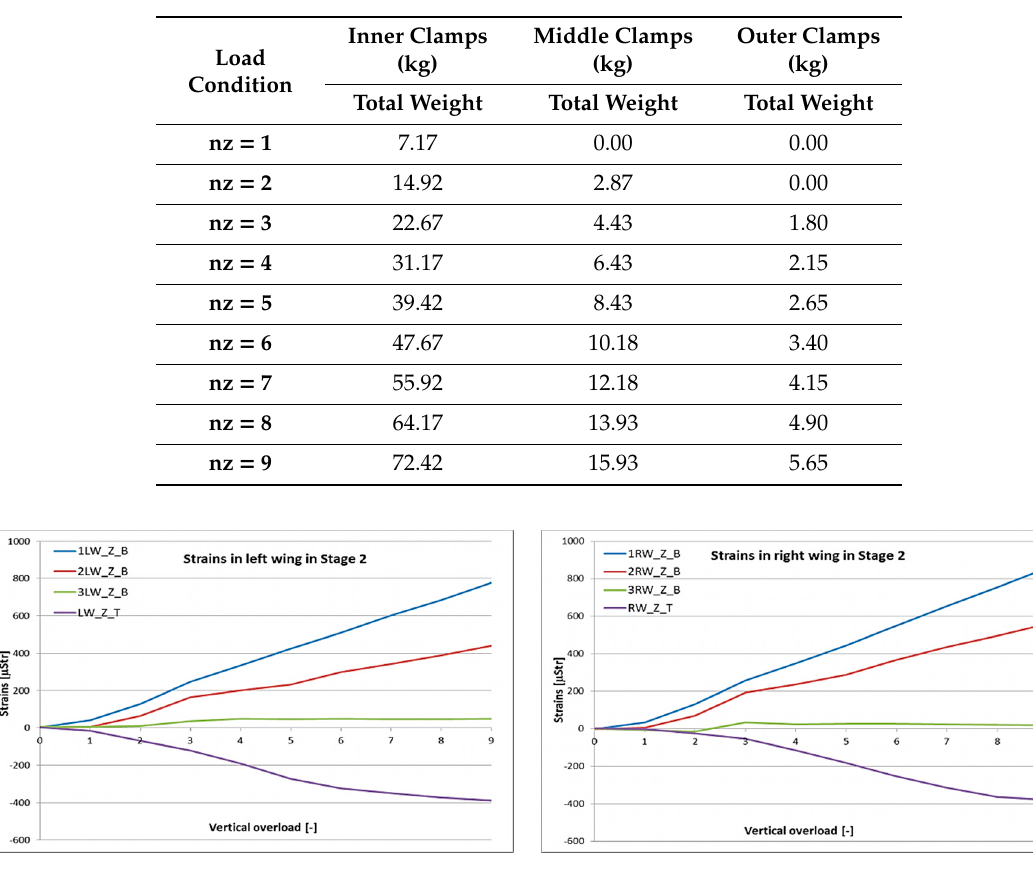
Table 2. Load conditions used in Stage 2—flight loads.